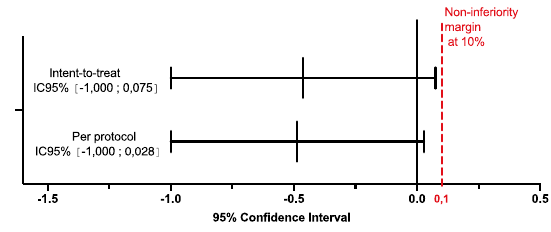
Fig. 1 Non‑inferiority testing, different in confidence interval of infec‑ tions rate between intent‑to‑treat and Per‑protocol